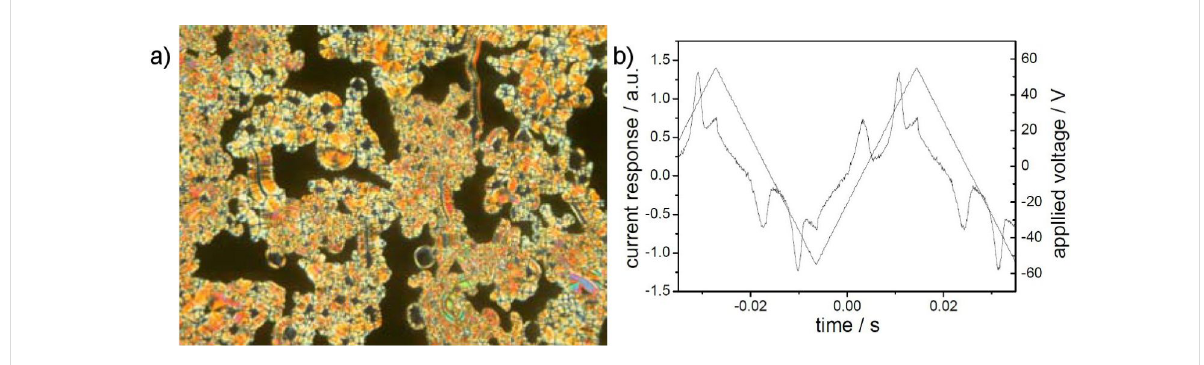
Figure 16: Compound OH 4d : a) Microphotograph of a growing fringe pattern of a SmCP phase upon cooling of the isotropic liquid; b) current response curve showing antiferroelectric behaviour ( U = 19 V/µm, 20 Hz, d cell = 6 µm, P S = 500 nC/cm 2 ).